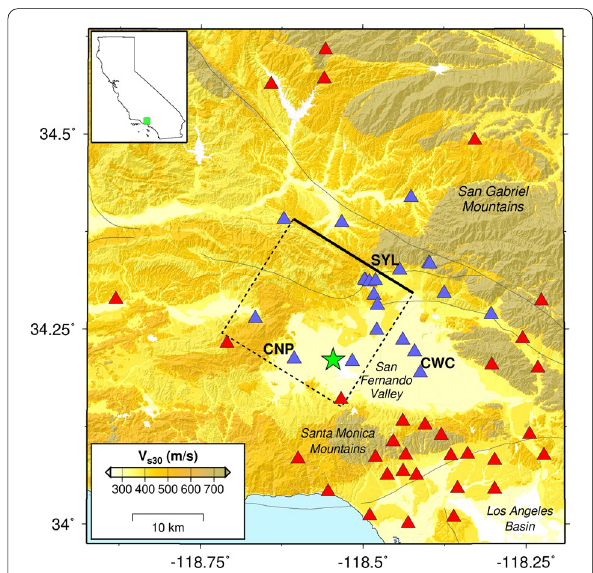
Fig. 2 Map showing Northridge earthquake rupture plane projected to ground surface (black rectangle) and strong motion sites within 15 km (blue triangles) and 30 km (red triangles) of the rupture surface. Epicenter indicated by green star. Color shading denotes V s30 values from Wills et al. (2015). Labeled sites discussed in